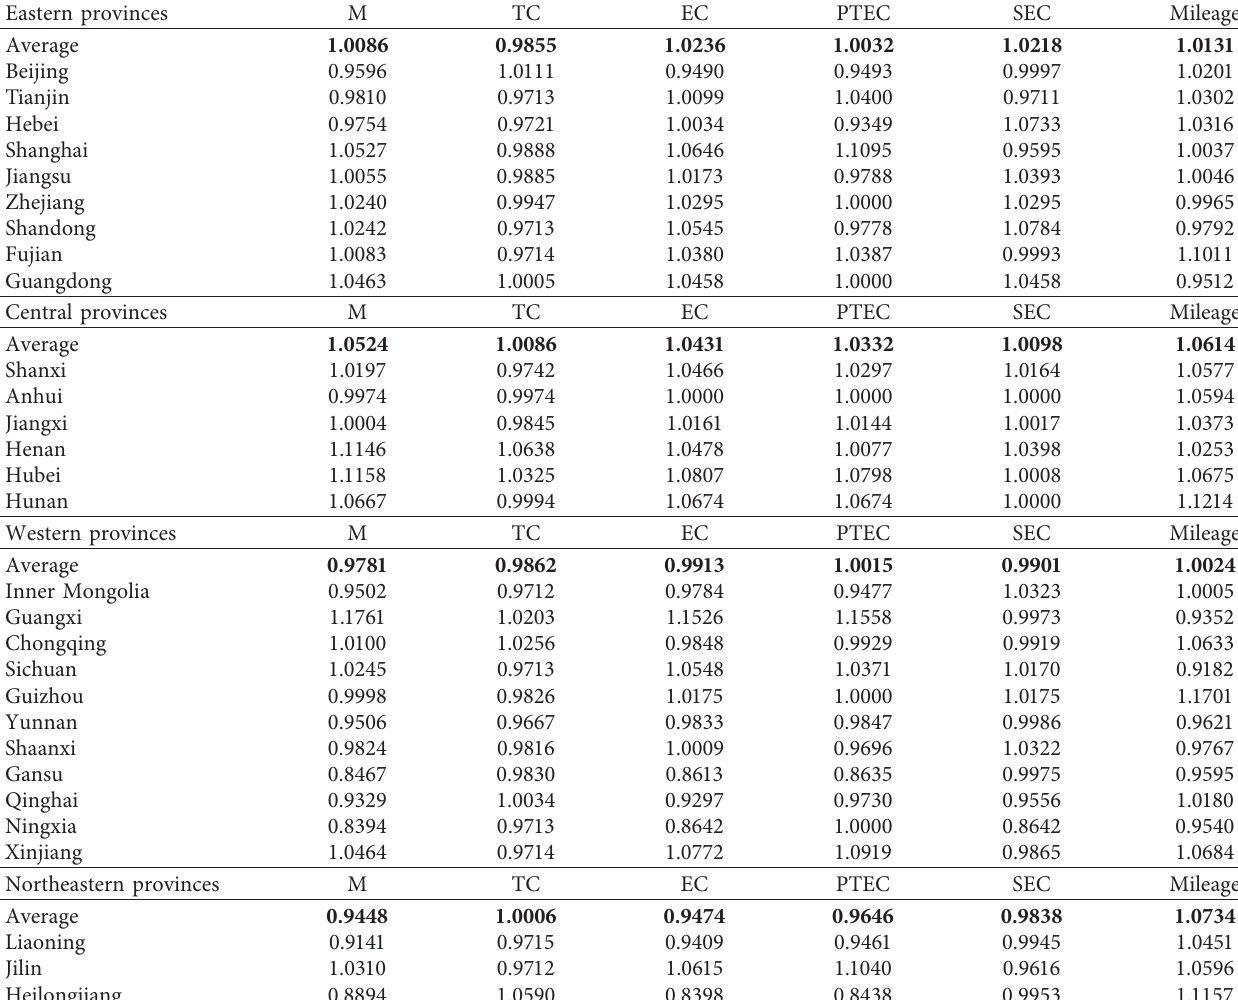
Table 2: Annual average operating efficiency and index breakdown by province between 2013 and 2017 (with 2010 as the base period). Eastern provinces